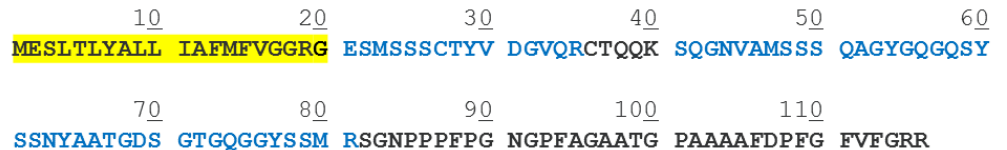
Figure 5. Translation of the gene sequence of GenBank accession number HQ005929.1 predicts a low molecular weight protein with 116 amino acids. Blue text corresponds to peptide sequences identified by MS/MS studies. Yellow coloration denotes a putative secretion signal sequence identified by the SignalP-5.0 server [28].